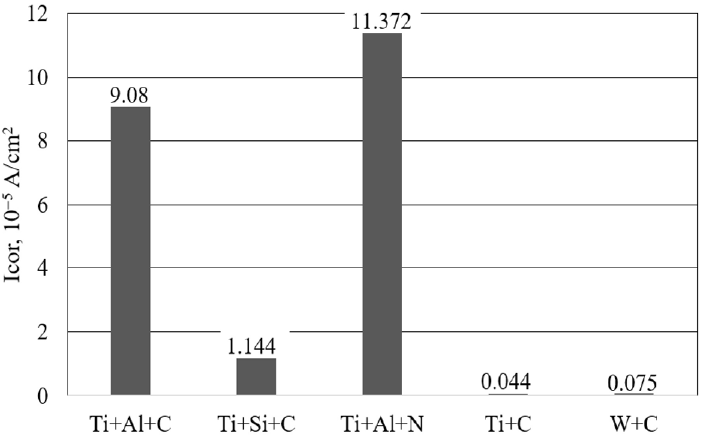
Figure 11. Corrosion current values for various electrospark coatings at current density 10 − 5 А /cm 2 .